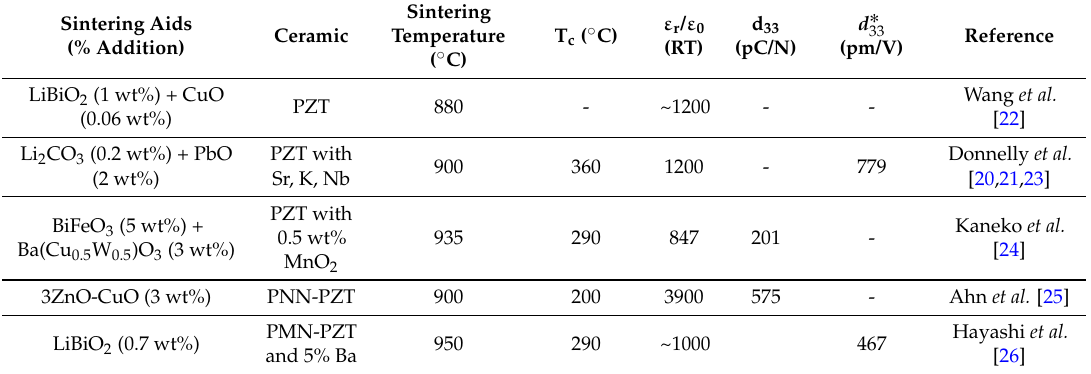
Sintering ε r / ε 0 d ˚ 33 d 33 Ceramic Temperature T c ( ˝ C) Reference (RT) (pC/N) (pm/V) ( ˝ C) Wang et al. PZT 880 - ~1200 - - [22] Donnelly et al. PZT with 900 360 1200 - 779 [20,21,23] Sr, K, Nb - - Ahn et al. [25] PMN-PZT and 5% Ba